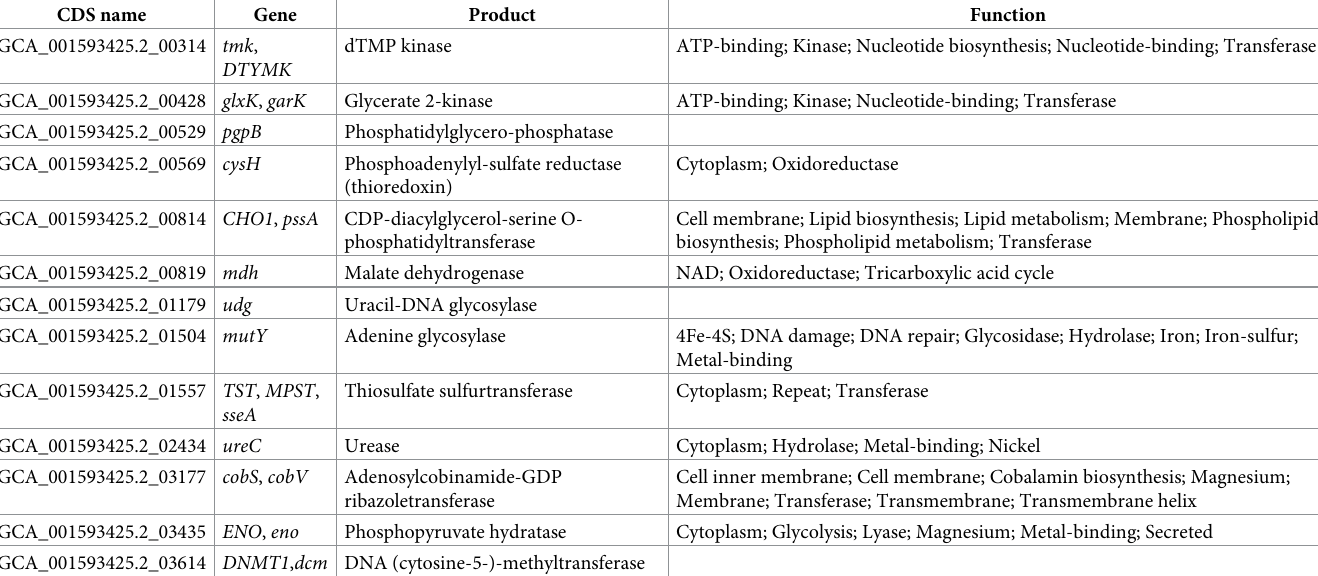
Table 2. The difference in CDS between A . baumannii ATCC 17978 and colistin-resistant A . baumannii using comparative genomic analysis. CDS